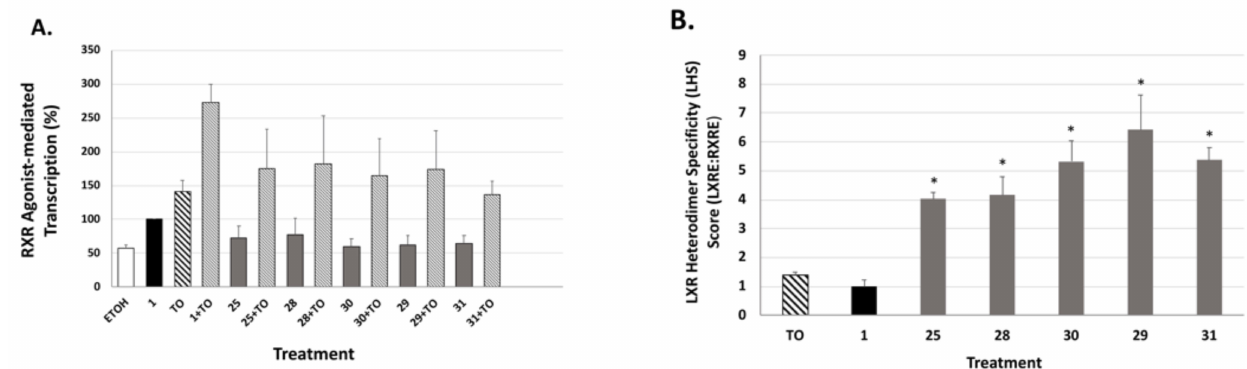
Figure 8. Evaluation of RXR agonists to potentiate LXRE-mediated transactivation in the absence and presence of LXR ligand T0901317. ( A ) HEK-293 human embryonic cells were transfected with pCMX-hLXR α , an expression vector for human LXR α , an LXRE-luciferase reporter gene with three tandem copies of the LXRE from the human ApoE gene, and a renilla control plasmid. Cells were transfected for 24 h utilizing a liposome-mediated transfection protocol and then treated with the ethanol vehicle, or 100 nM of the indicated compound alone or in combination with 100 nM TO901317 (TO). LXRE-directed activity was compared to compound 1 (bexarotene), set to 100%. ( B ) The “Heterodimer Specificity Score” (LHS) was determined by calculating the LXRE:RXRE activity ratio of each analog, with compound 1 set to 1.0. Values are means ± SD with indicated analogs exhibiting greater LHS vs. compound 1 (* p < 0.05).